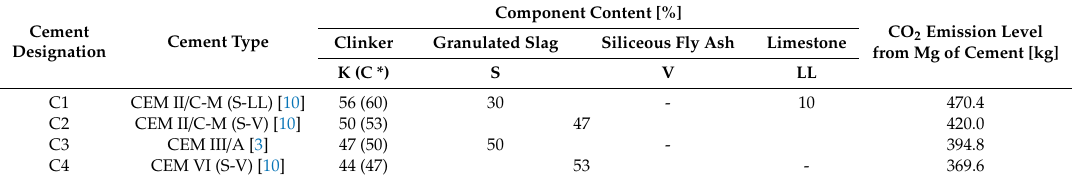
Table 3. Composition of low-emission cements and CO 2 emission level.